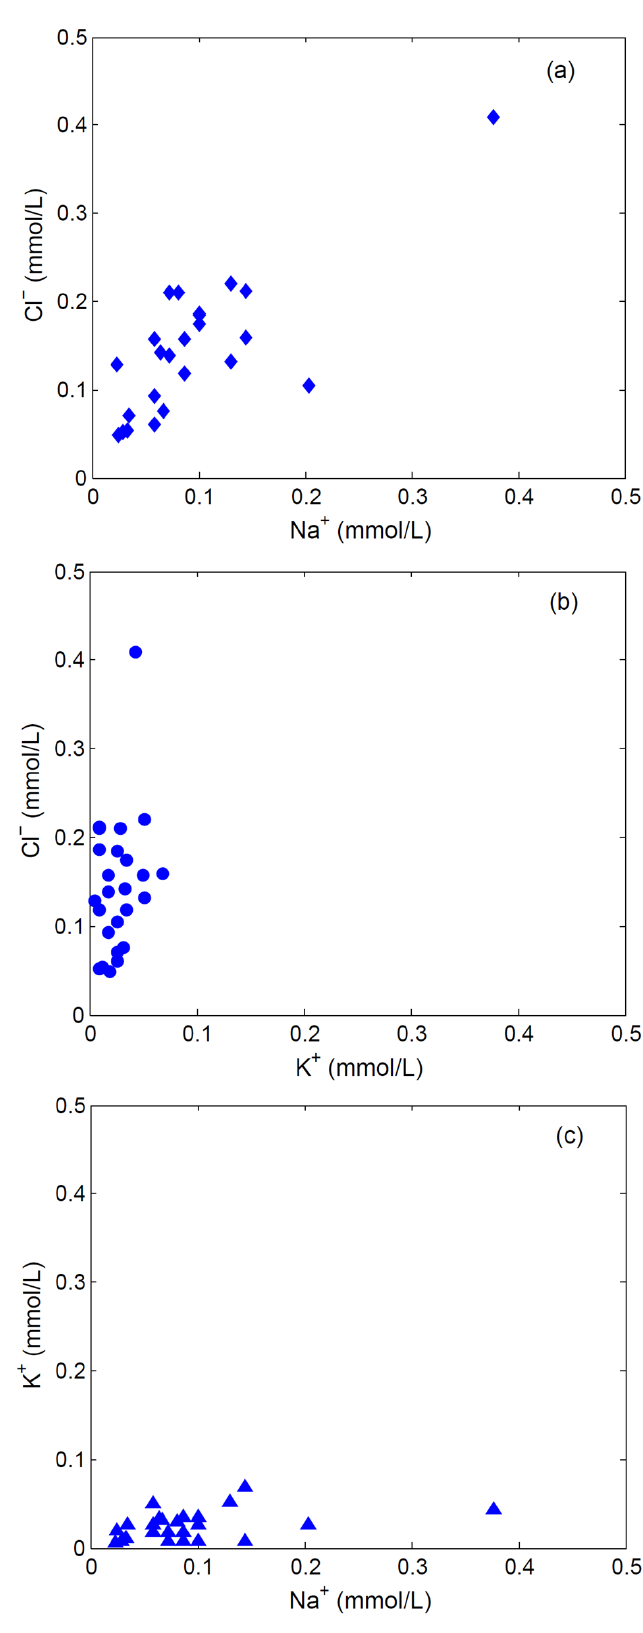
Figure 3. Correlation between ( a ) Na + and Cl − ; ( b ) K + and Cl − ; ( c ) Na + and K + ions in the karst groundwater samples collected from the studied dolomite aquifer between 2008 and